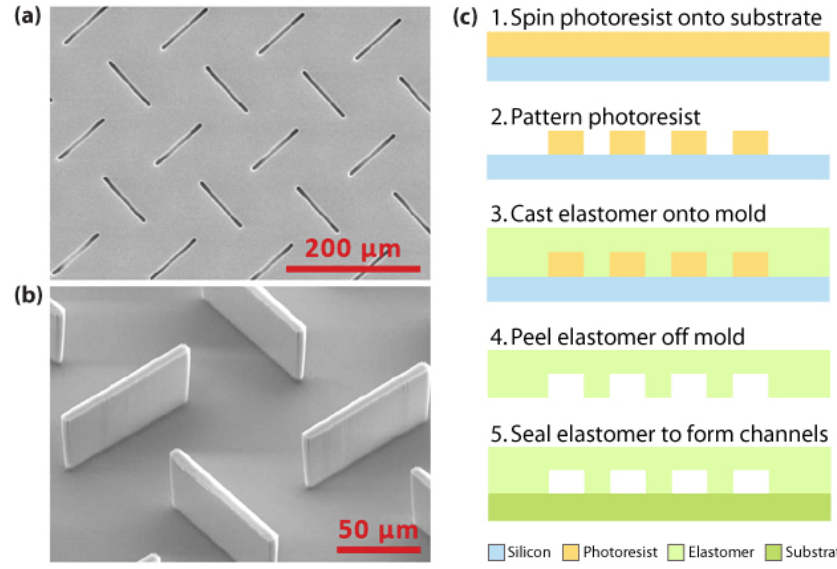
Figure 2. SEM micrograph of (a) PDMS mold for plastic casting and (b) the epoxy chip fabricated by casting (reprinted with permission [37] © 2007 Springer); (c) Schematic of the casting method showing an elastomer material poured over a molding template, peeled off, and sealed with an appropriate substrate, such as glass or silicon, to form microfluidic